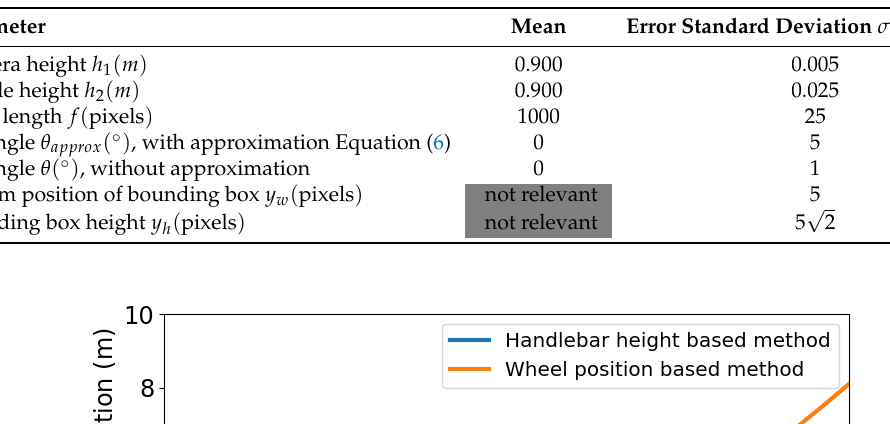
Table 2. Estimated mean and standard deviations of the normally distributed parameters in our simulations. These estimations were obtained through observation of realistic measurements. Note that the standard deviation for h 2 is significantly bigger than the standard deviation for h 1 because the latter can be measured much easier in a real application. Furthermore, we assume that the standard deviation for the error on θ is much smaller when it is actually measured (e.g., in Equation (4)) than when we assume it is always 0 (e.g., in Equation (6)). Finally, we note that the means of y w and y h are both distance dependent, so we did not include them in this table.